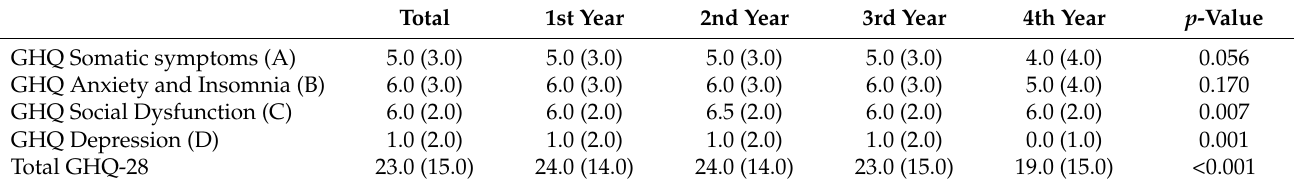
Table 2. General Health Questionnaire scores (dimensions and total score) by